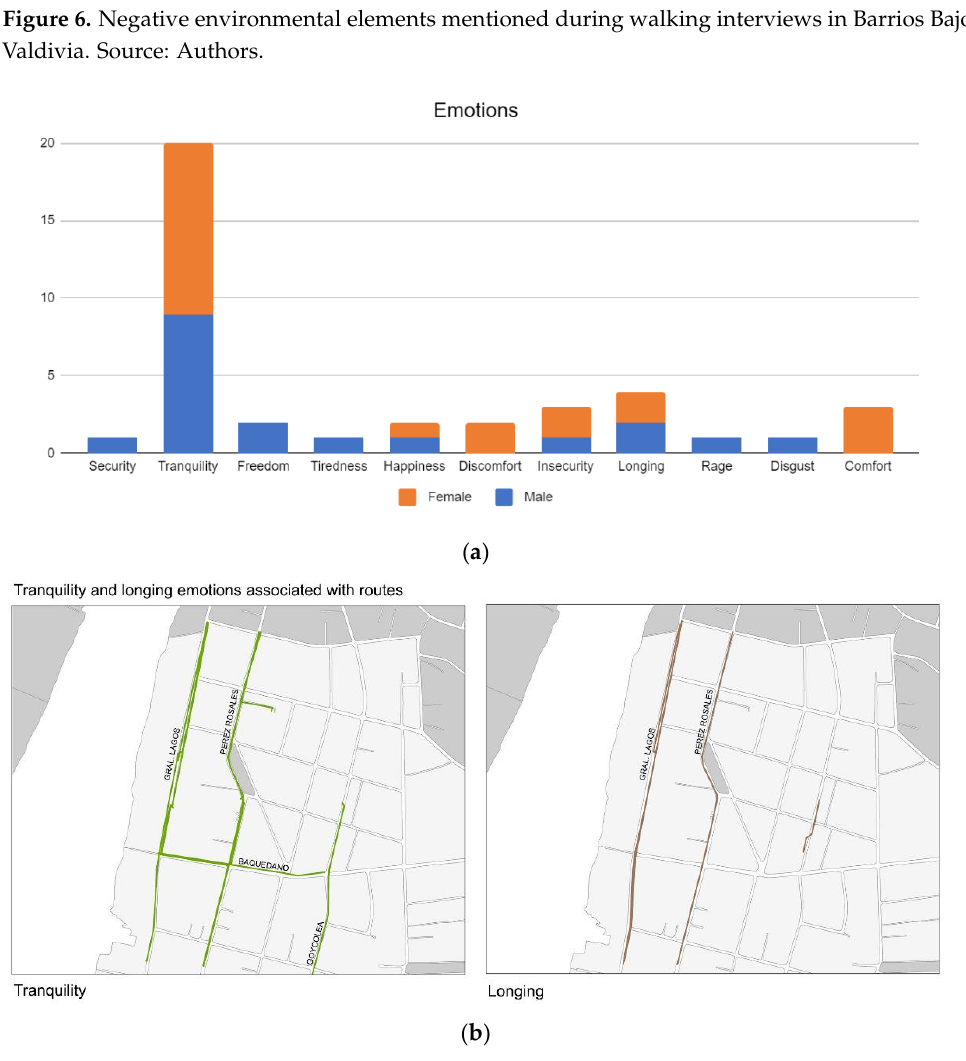
Figure 7. ( a ). Emotions mentioned during walking interviews in Barrios Bajos, Valdivia.